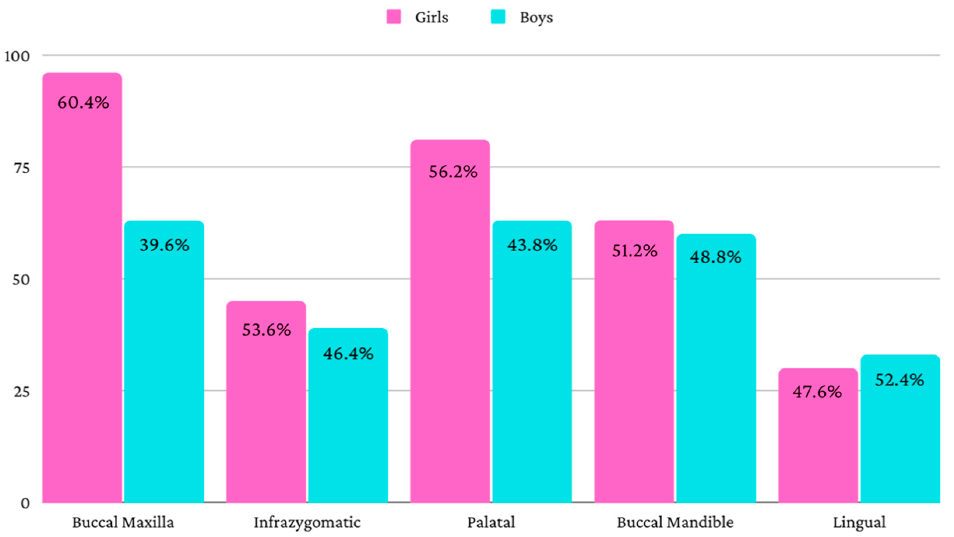
Figure 1. Distribution of the mini-implants for girls and for boys. Most of the analyzed patients had only one mini-implant (65.7%, n = 284) or two mini- implants (32.9%, n = 142). Only a small percentage of 0.70% of patients received three ( n = 3) or four ( n = 3) mini-implants.